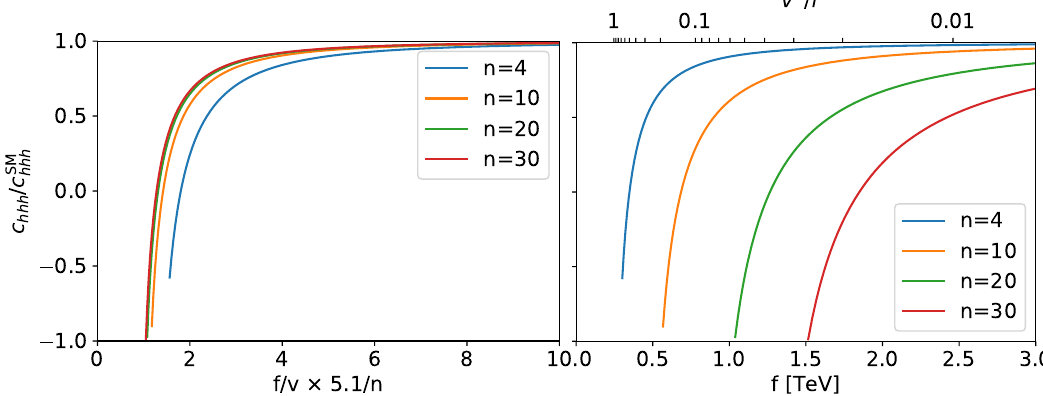
Figure 5 . The Higgs trilinear coupling normalised to its SM value, for the potential in eq. (3.6) including both Gegenbauer and top-sector contributions. Its behaviour as a function of f is inde- pendent of the top partner mass scale M T